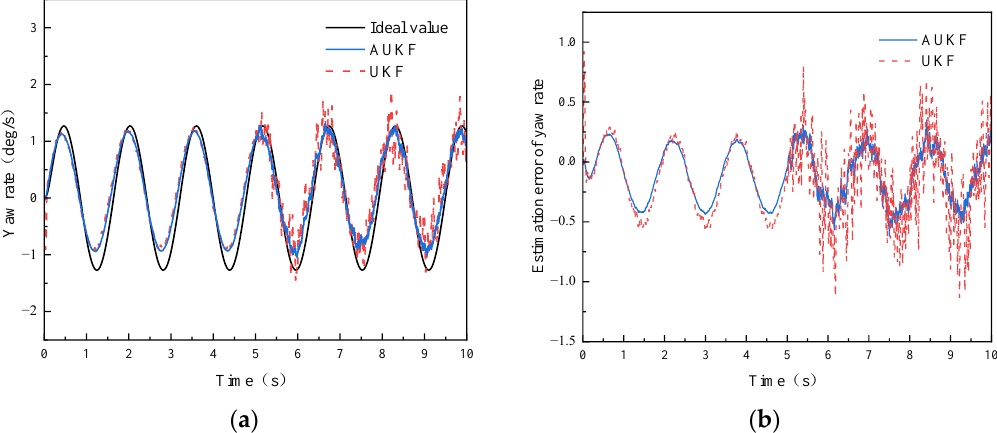
Figure 12. Simulation results of yaw rate. ( a ) Comparison of estimated results and ( b ) comparison of estimated error.